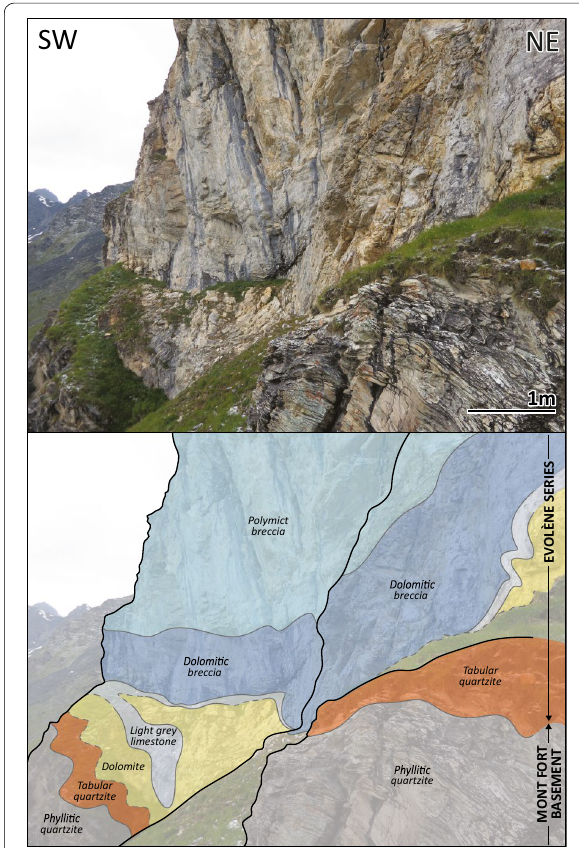
Fig. 11 Contact of the Mesozoic Evolène Series over the Mont Fort Paleozoic basement in the Roux area at locality [595 ′ 420/101 ′ 870] (cf. Figs. 6–8). The basement is formed by a phyllitic quartzite that belongs to the uppermost levels of the Permian Greppon Blanc Fm.. The cover exposes the normal succession of the L. Triassic pure quartzite, M. to U. Triassic dolomite, Early Jurassic bedded limestone and the thick L. to U. Jurassic breccias. The contacts between the formations are concordant although affected by a strong Alpine